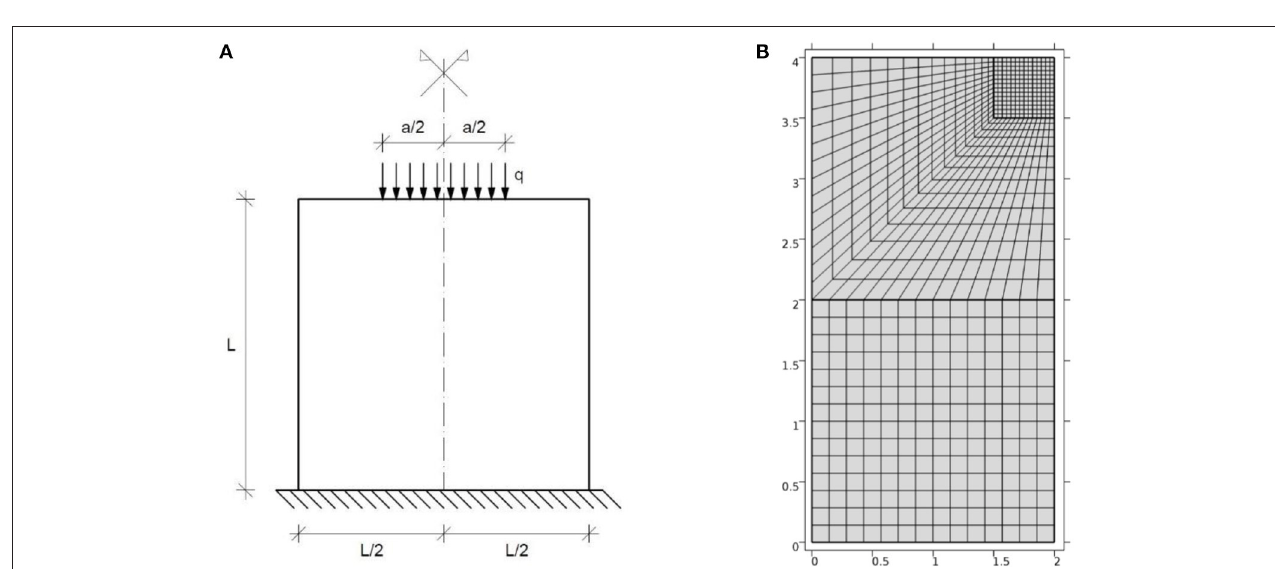
FIGURE 1 | (A) Sketch of the present problem with (B) present finite element mesh.